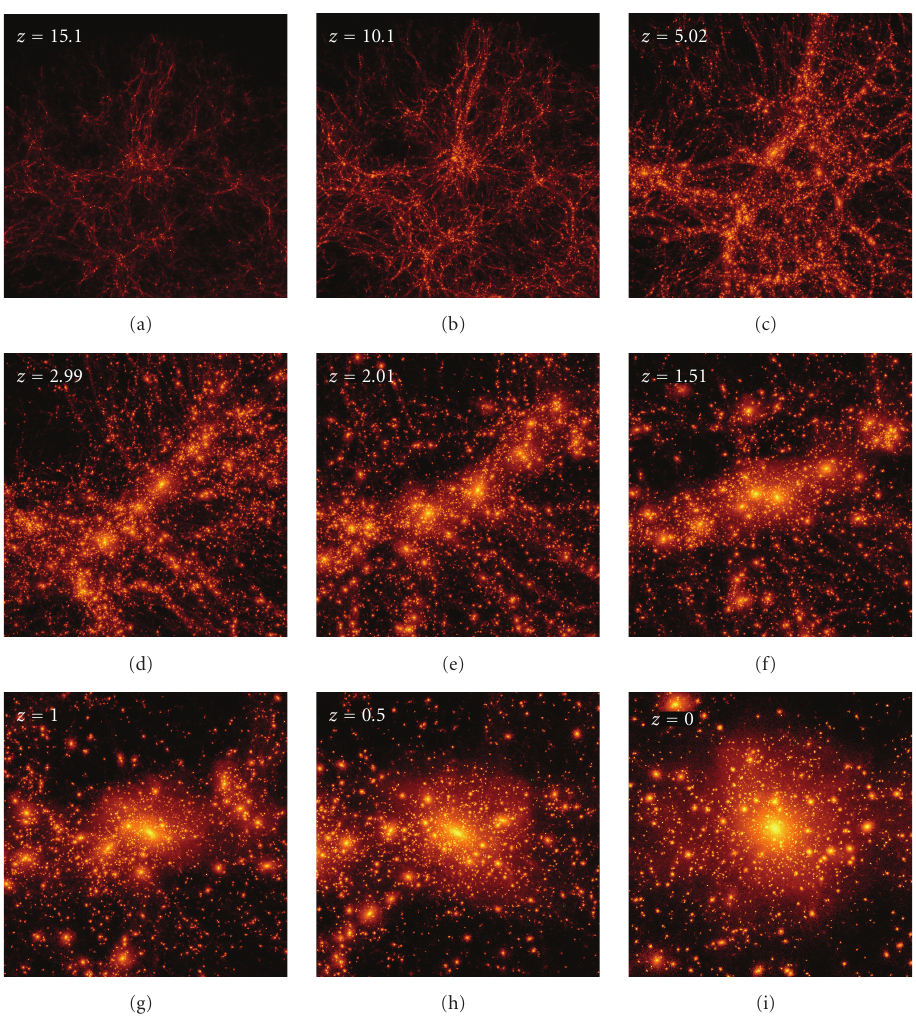
Figure 1: Formation of a Milky Way-sized dark matter halo in a cosmological simulation of flat Λ CDM cosmology ( Ω m = 1 − Ω Λ = 0 . 3, h = 0 . 7, σ 8 = 0 . 9). The panels show an evolutionary sequence at nine redshifts (from left to right and from top to bottom) focusing on the most massive progenitor of the main halo at each epoch (redshift of each epoch is shown in the left upper corner). The rendering shows the dark matter particles with intensity indicating the local matter density on a logarithmic stretch. The build-up of the halo proceeds through a series of spectacular mergers, particularly frequent in the early stages of evolution. Many of the merging clumps survive until the present epoch ( z = 0) in the form of “substructure.” The size of the region shown is about 3 comoving Mpc at z = 15, monotonically zooming in to a scale of ≈ 1 comoving Mpc across at z =